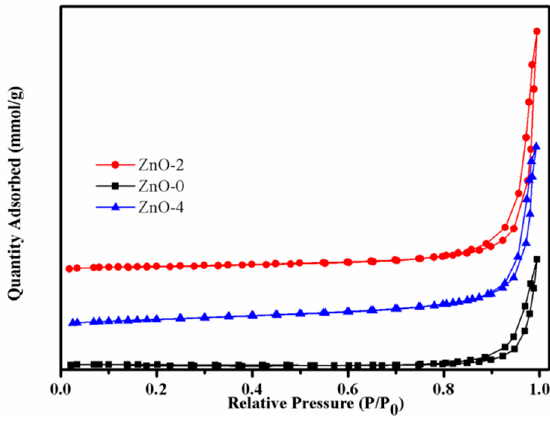
Figure 4. Nitrogen absorption–desorption isotherms of the samples ZnO-0, -2 and -4.